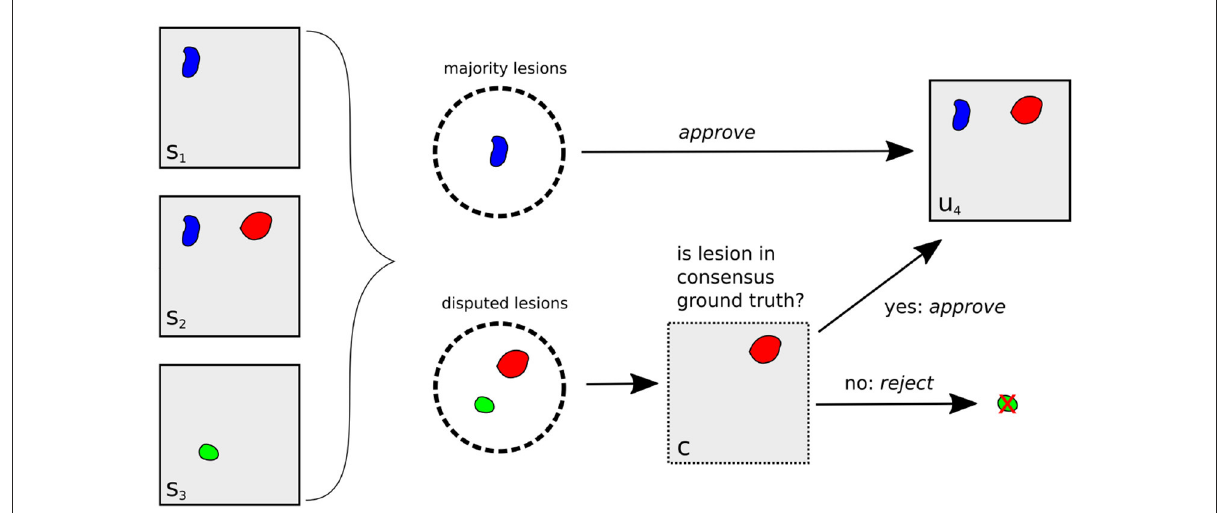
FIGURE3 Illustration of unbiased ground truth creation u 4 for Expert 4, (right) from the segmentation masks of experts 1, 2, and 3 (left). If a lesion is found by at least two experts (blue lesion), it is automatically selected for u 4 . Otherwise, it is a disputed lesion (green, red) and has to be decided on by the senior expert. If it is contained in the consensus ground truth c (red lesion), it has been accepted by the senior expert before, so we approve it. Otherwise, it is